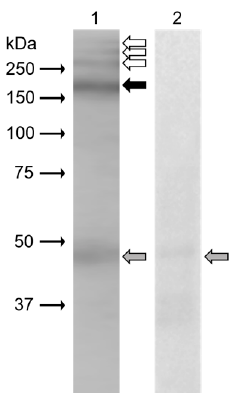
Figure 3. Western blot immunodetection of the β 4 integrin in protein extract from mouse epididymal sperm with mouse monoclonal anti- β 4 integrin (sc-13543) antibody; (1) antibody reaction in protein extract from mouse sperm, (2) negative control with mouse IgG; detection of 200 kDa protein band corresponds to β 4 integrin (black arrow), possible high molecular weight isoforms (white arrows), non-specific reaction (grey arrows).